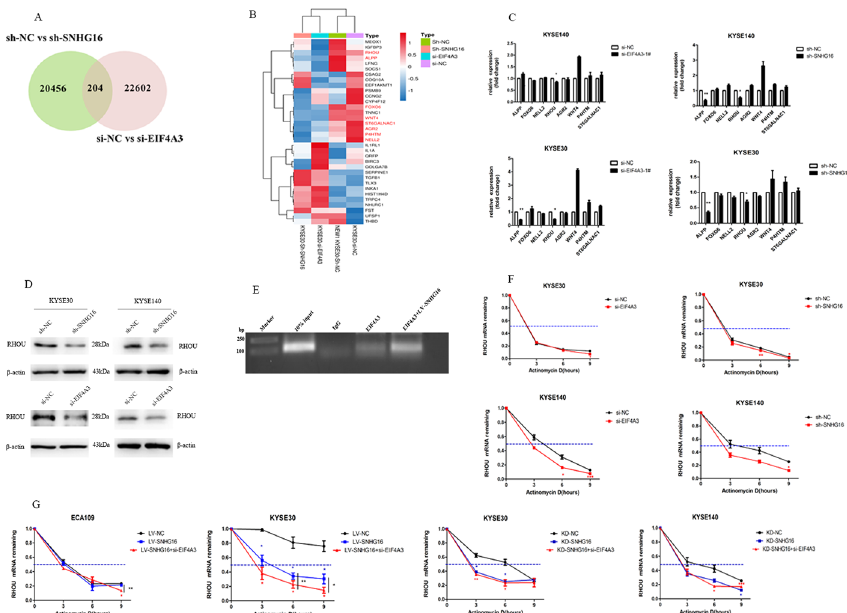
Fig. 5 SNHG16–EIF4A3 regulates RhoU and affects its mRNA stability. A A total of 204 transcripts were altered simultaneously in sh-SNHG16-treated cells and si-EIF4A3-treated cells (fold-change > 1.5, P < 0.05). B The hierarchical cluster heatmap of the 204 differentially expressed mRNAs in RNA-Seq analysis of sh-SNHG16-treated cells and si-EIF4A3-treated cells. Red represents upregulated transcripts, and blue represents downregulated transcripts. C qRT-PCR validated the changes in eight mRNAs involved in the regulation of sh-SNHG16 and si-EIF4A3. D Western blot analysis of RhoU after SNHG16 or EIF4A3 downregulation in ESCC cells. GAPDH was used as an internal control. E RIP showed that EIF4A3 interacted with RhoU and increased under SNHG16. F RNA stability assays were performed to measure the degradation rates of RhoU mRNA in KYSE30 and KYSE140 cells with SNHG16 or EIF4A3 knockdown. G RhoU mRNA stability in ESCC cells with LV-SNHG16 cells, KD-SNHG16 cells, and EIF4A3 knockdown in LV-SNHG16-treated cells and KD-SSNHG16 cells. * P < 0.05, ** P < 0.01, *** P <